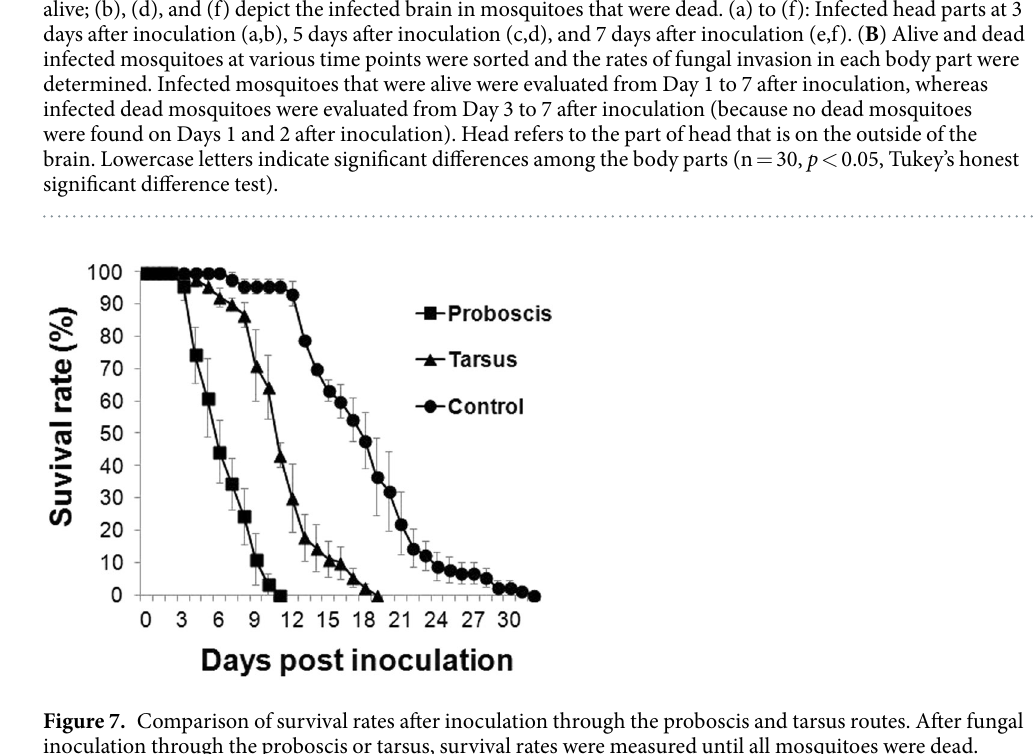
phosphatase, and then induce upward locomotory activity of the Lepidopteran host 16 . In the case of the fungal pathogen Ophiocordyceps unilateralis s.l ., a high density of hyphal bodies was observed in the head of the host ant, Camponotus leonardi , before host death 17 . This phenomenon was suggested to reflect the strategy used by the parasite to manipulate host behaviour before host death: O. unilateralis s.l . was reported to specifically invade the brain tissues of its naturally occurring host ant, C. leonardi 20 . Our study here showed that the rate of fungal invasion of the head part (outside of the brain) was higher than that of any other body part examined (Fig. 5). B. bassiana and M. anisopliae are recognised to affect certain behaviours of their hosts: the fungi caused reduced searching and blood-feeding frequency in An. gambiae and An. stephensi 21–24 . Thus, such behavioural changes